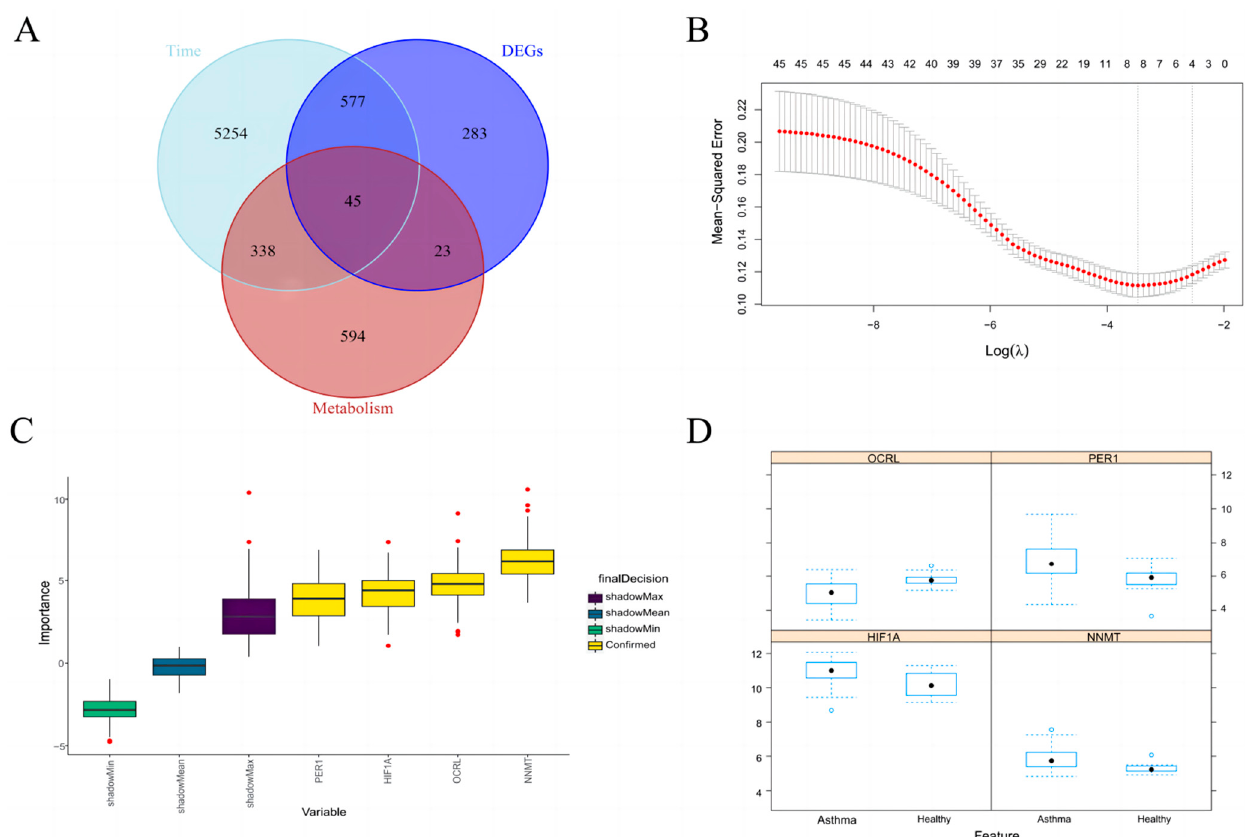
Figure 2. Intersected genes and further screening of genes. ( A ) Venn figure for intersected genes in time series analysis, metabolic genes, and DEGs. ( B ) The gene signature selection of optimal parameter (lambda) in LASSO model; the dashed line on the right indicates the λ value of the model with the evaluation index in the best value of 1 standard error range, lambda.1se. ( C ) The expression of module genes in the dataset GSE76262. ( D ) Importance of each factor in the RF model based on GSE76262.